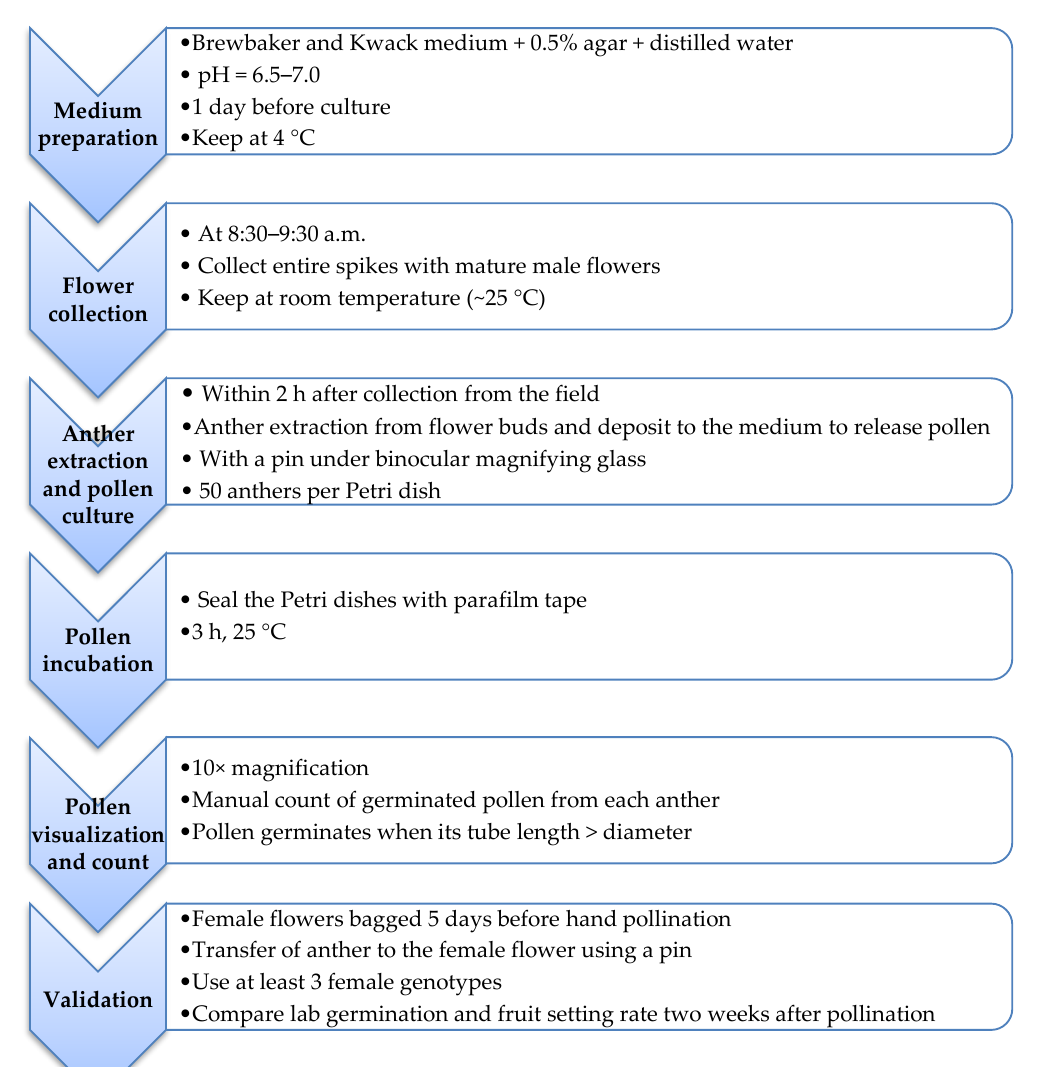
Figure 6. Schematic presentation of the optimized protocol for in vitro pollen germination testing in Dioscorea spp.